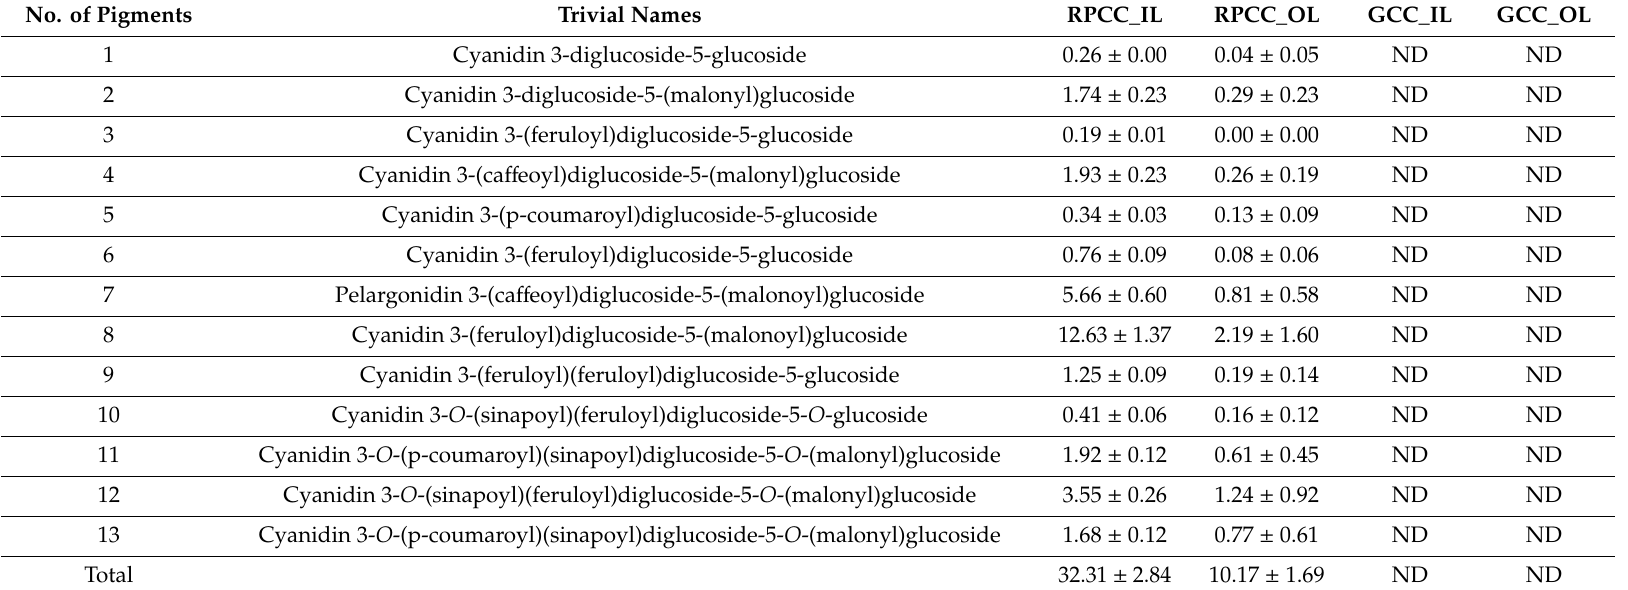
Table 1. Total anthocyanin pigments identified in outer and inner leaf tissues of reddish purple and green Chinese cabbage. No. of